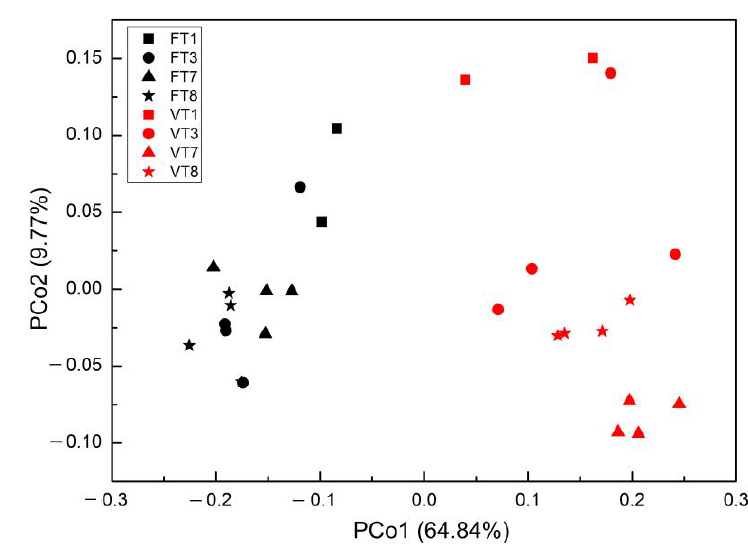
Figure 2. The principal coordinate analysis of prokaryotic communities of 14 mmol/L disodium fumarate (DF) groups (FT3 and VT3), 80 mg/kg monensin sodium salt (MSS) groups (FT7 and VT7), 7 mmol/L DF and 80 mg/kg MSS groups (FT8 and VT8), and control groups (FT1 and VT1).